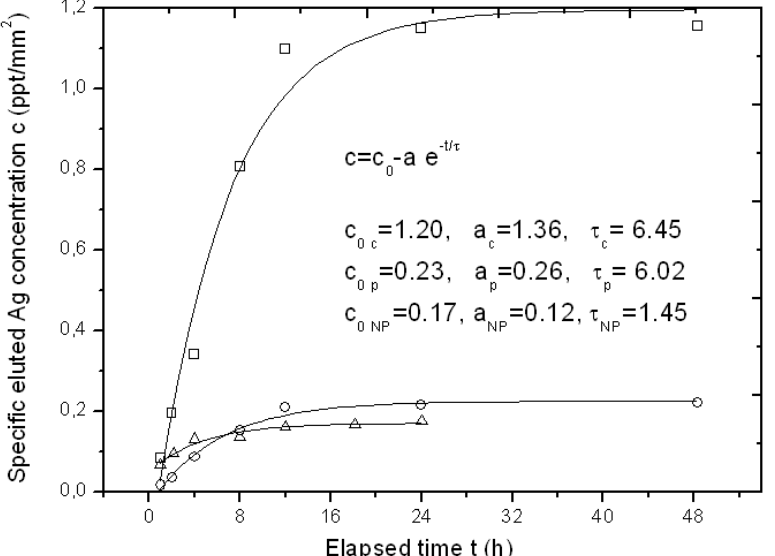
Figure 4. Typical curves of eluted Ag concentration per unit surface area from APA loaded with the three different loading methods up to the first two days, with respective fitting parameters to an exponential growth model. The symbols legend for experimental datapoints is as follows: Squares ( □ ) are used for chemical loading, circles ( ○ ) for physical loading and triangles ( Δ ) for NPs